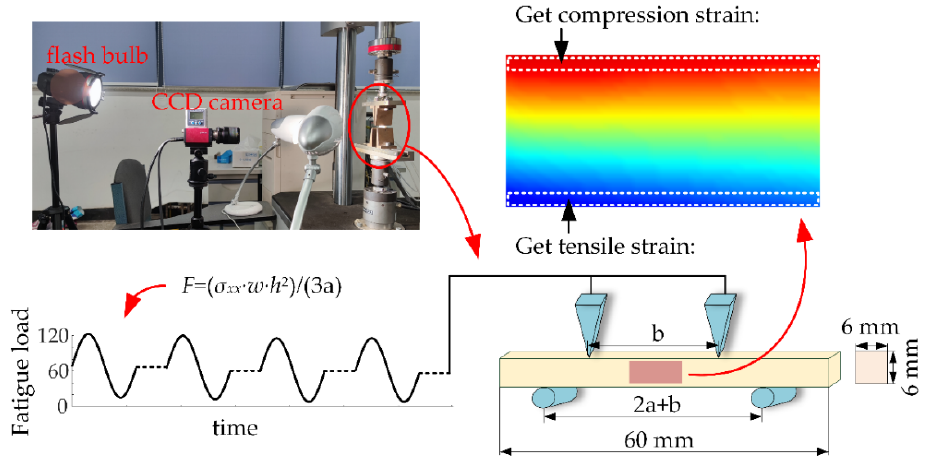
Figure 4. The four-point bending fatigue